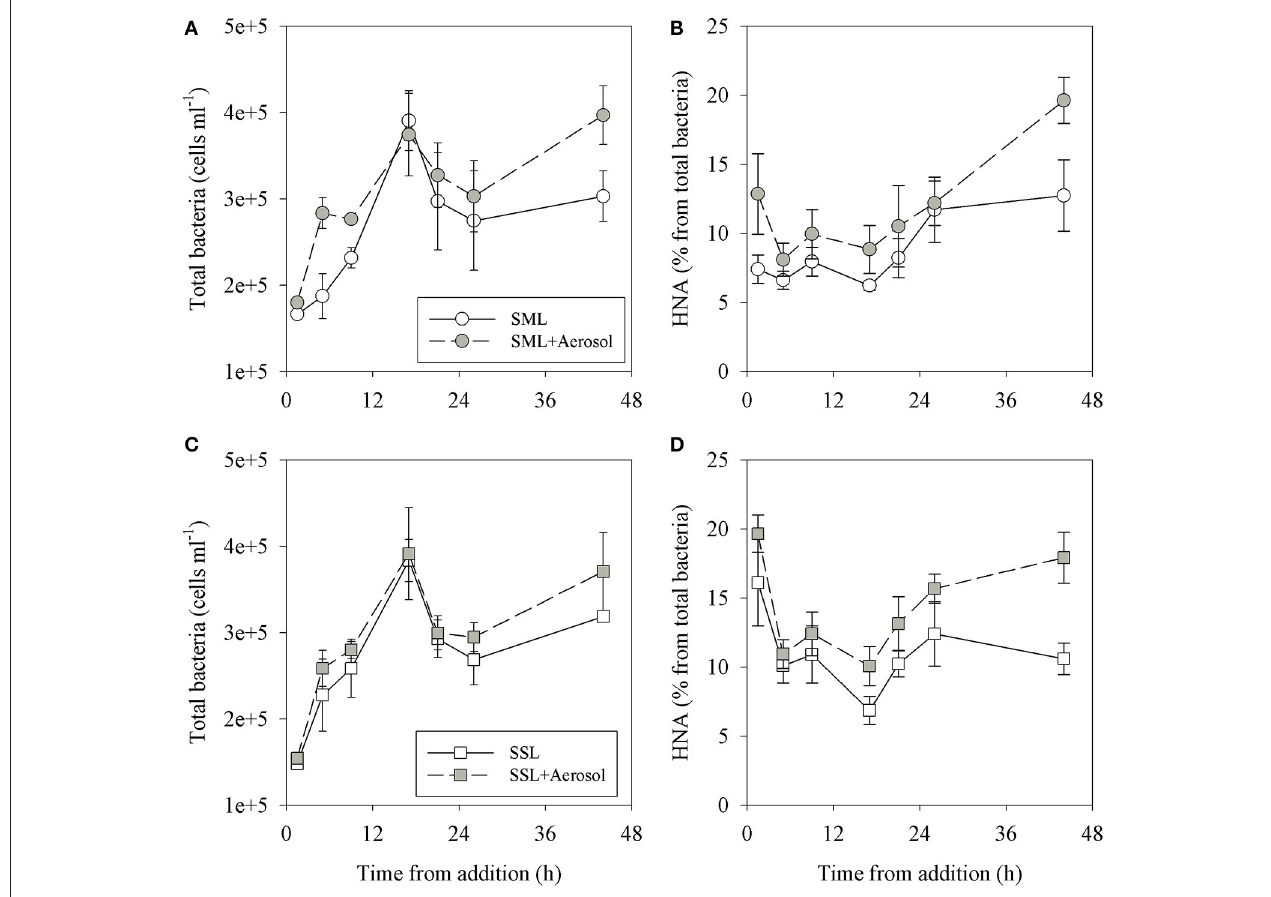
FIGURE 2 | The temporal dynamics of total heterotrophic bacteria (A,C) and the percentage of HNA from the total bacteria (B,D) in the SML (A,B) and SSL (C,D) layers. Experiments including aerosol additions (1.5mg L − 1 ) are presented in gray, control experiments (containing no additions) are colored white. Values are the averages and standard deviation from 3 biological replicates ( n =